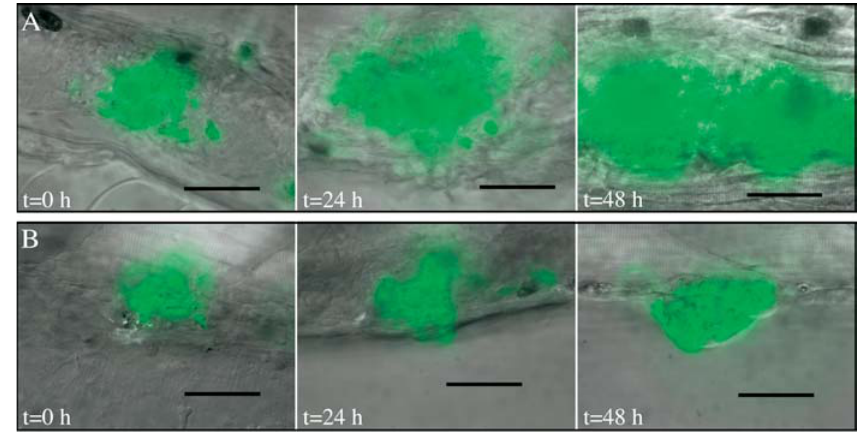
Figure 4. Progression of Aggregates a WT Aggregate (A), and a D RD1 Aggregate (B) (A) WT aggregates shown on the first day of aggregate formation ( t = 0 h); 24 h after aggregate formation ( t = 24 h); and 48 h after aggregate formation ( t = 48 h). (B) D RD1 aggregates shown at the same time points as in (A). A 60 3 water lens was used for all photo- micrographs except the image in (A) t = 48 h, which was taken with a 40 3 lens. Scale bar represents 50 l